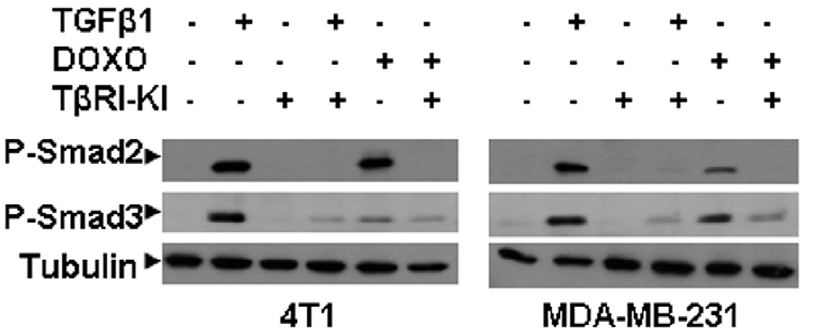
Figure 2. Enhanced phosphorylation of Smad2 and Smad3 in murine and human breast cancer cells by doxorubicin and TGF b treatment. The murine 4T1 and human MDA-MB-231 breast cancer cells were treated with doxorubicin (25 nM) or TGF b 1(2 ng/ml) in the presence or absence of TGF b antagonist TbRI-KI (500 nM) for 7 days. The medium was changed every alternate day. The cell extracts were used for Western blotting analysis to measure the levels of phosphorylated Smad2 (P-Smad2) and phosphorylated Smad3 (P-Smad3) with their respective